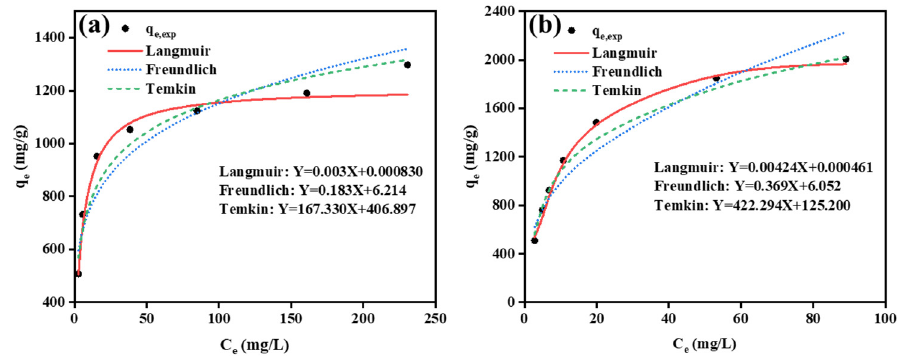
Figure 6. Adsorption isotherms of CTC onto ( a ) Cu 2 MoS 4 and ( b ) FeMoS 4 (C sorbent = 0.2 g/L). Table 3. Comparison of different adsorbents for optimal CTC adsorption capacity.